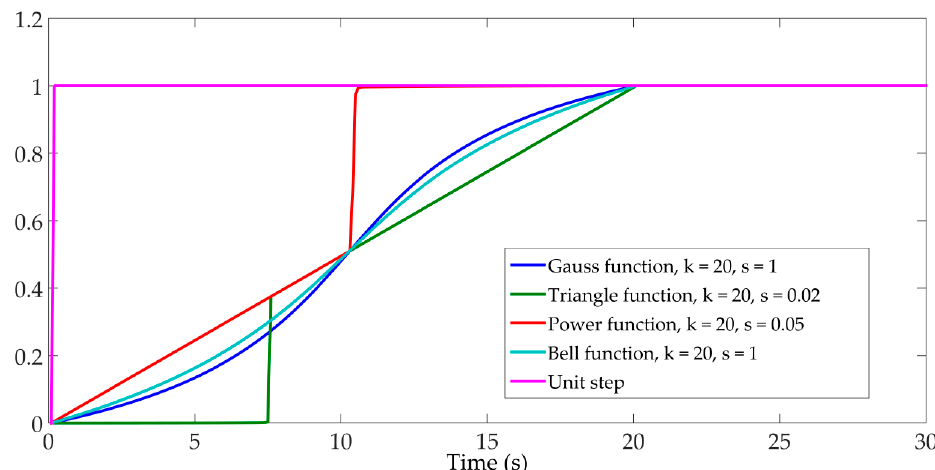
Figure 7. Filter time responses to unit step for various membership functions.